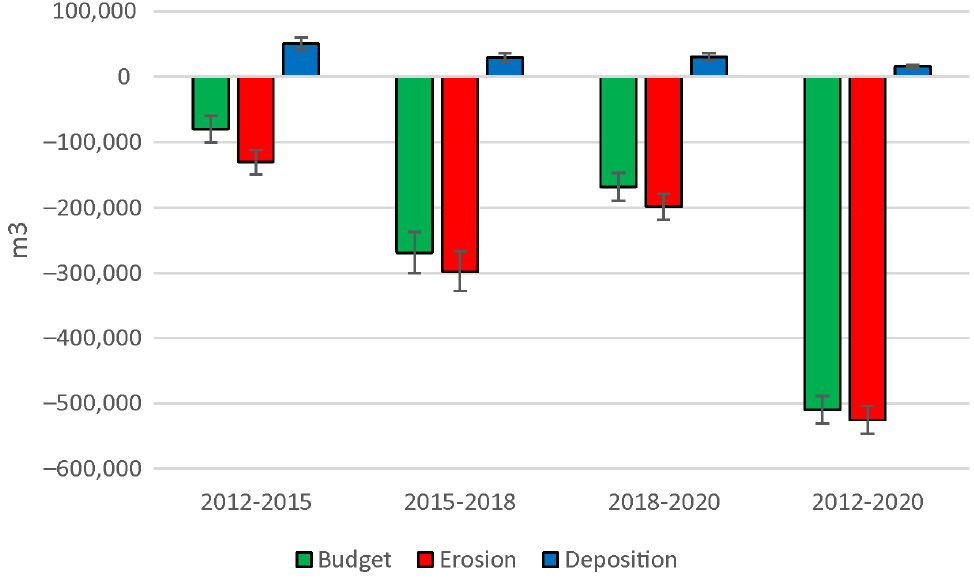
Figure 6. Volume changes of the cliff in the analyzed time intervals. Raw data source—Maritime Office in Szczecin. Table 6. Sediment losses during the observation periods. Raw data source—Maritime Office in Szczecin.